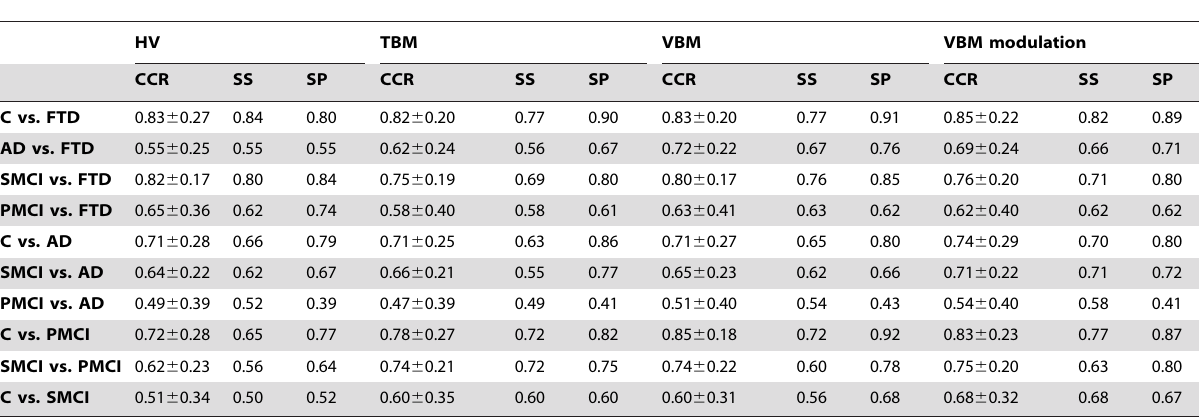
Table 2–5: HV=Hippocampal Volumes; TBM=Tensor-based morphometry; VBM=Voxel-based morphometry; CCR=Correct Classification Accuracy; SS=Sensitivity; SP=Specificity; C=Control; SMCI=Stable Mild Cognitive Impairment; PMCI=Progressive Mild Cognitive Impairment; AD=Alzheimer’s disease; FTD=Frontotemporal